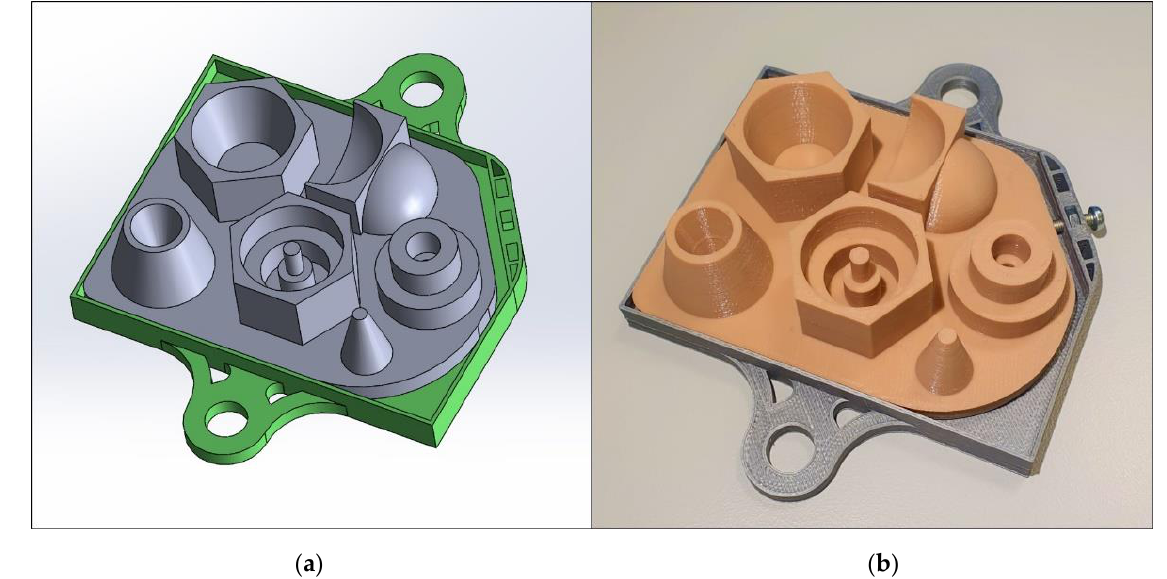
Figure 14. Fixture design for test artifact. ( a ) Assembled CAD-drawing. ( b ) The fixture with a prototype of the test artifact in place.